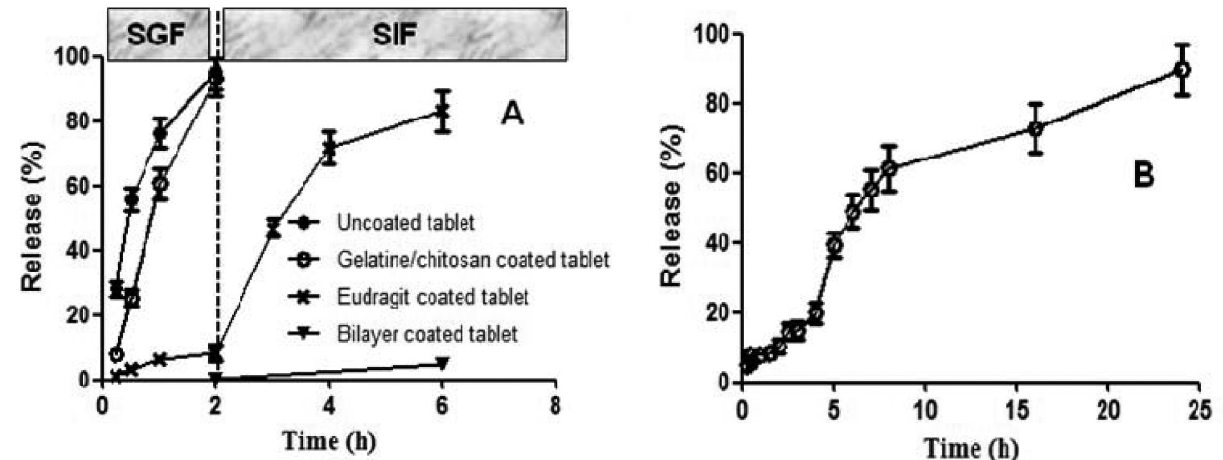
FIGURE 6 - Dissolution profiles of uncoated tablet and gelatin/chitosan, Eudragit and bilayer-coated tablets in SGF and SIF (A), and bilayer-coated tablet in SCF after it was tested in SGF for 2 h and SIF for 4 h (B). TABLE IV - Physicochemical properties of bilayer-coated tablet during 6-month accelerated stability studies Time